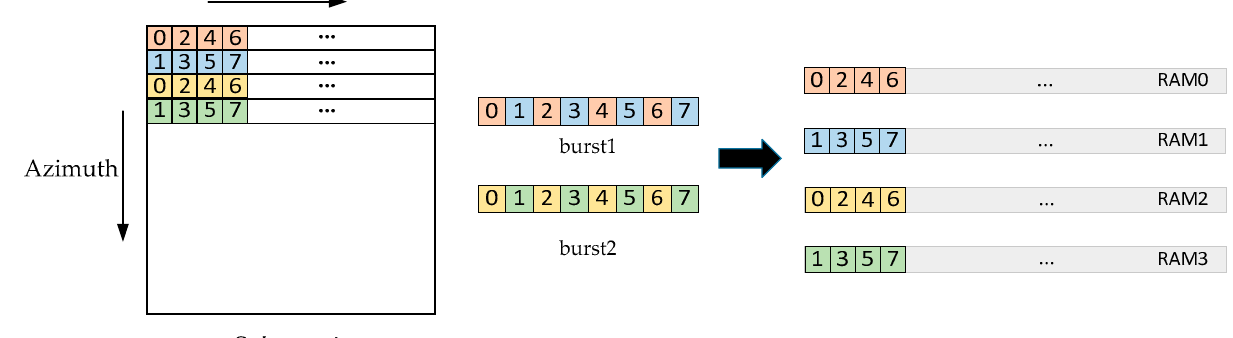
Figure 10. De-cross access and caching in range direction.